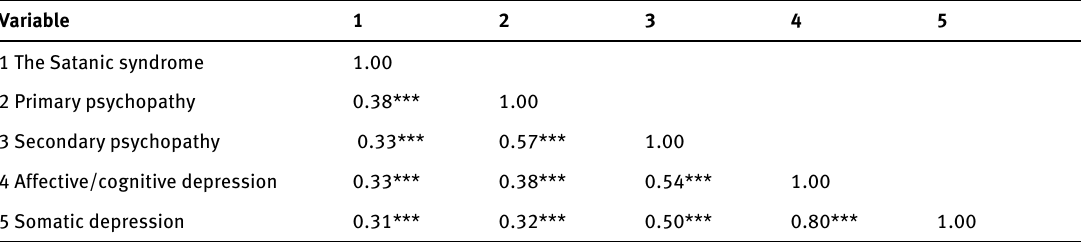
Table 3. Correlations among the Satanic syndrome and subscales for psychopathy and depression within a total sample